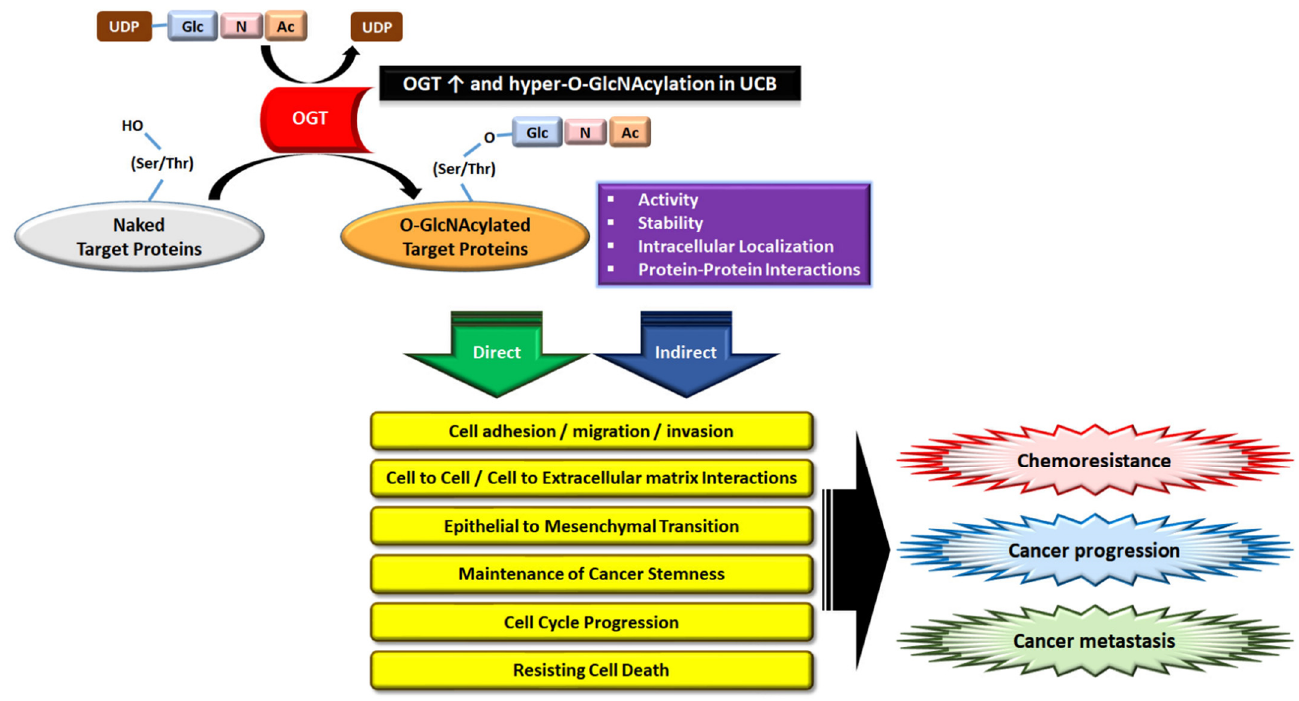
Figure 6. Graphical representation of potential models of enhanced chemoresistance and tumor aggressiveness mediated by upregulated OGT activity and hyper ‐ O ‐ GlcNAcylation in UCB. Glc, glucose; UDP ‐ GlcNAc, uridine diphosphate N ‐ acetylglucosamine. O ‐ GlcNAcylation is a dynamic post ‐ translational modification occurring on serine (Ser) and threonine (Thr) residues of nuclear and cytoplasmic target proteins.